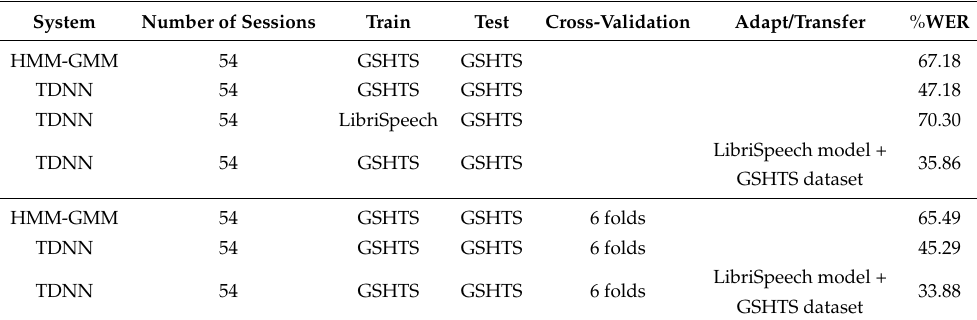
Table 2. ASR system results using transfer learning and cross-validation techniques; for each model the data used for training, testing and transfer learning has been